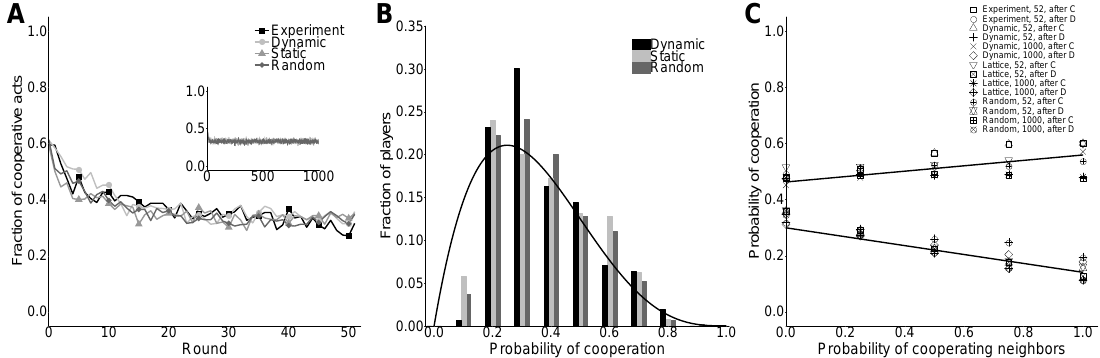
Figure 1. Simulation of Zaragoza’s experiment. ( A ) Fraction of agents who cooperated in each round of the game on the Zaragoza experiment (black line with square), dynamic lattice treatment (light gray line with circle), static lattice treatment (medium gray line with triangle) and regular random network treatment (dark gray line with diamond). The inset shows the same results for a larger number of rounds. ( B ) Fraction of agents that reached a certain probability of cooperation in the game on the dynamic lattice treatment (black), static lattice treatment (light gray) and regular random network treatment (dark gray). The continuous black line shows the Ansatz µ ( P ) = 2 P ( 1 − P ) 3 described in Appendix A. ( C ) Probability for a generic agent to cooperate after she cooperated (after C) or after she defected (after D) in the three different treatments (Dynamic, Lattice and Random) assuming the length of the simulation is 52 or 1000 rounds. The straight black lines with positive and negative slopes show, respectively, the MCC values for after C and after D obtained by using the Ansatz µ ( P ) and the equations described in Appendix